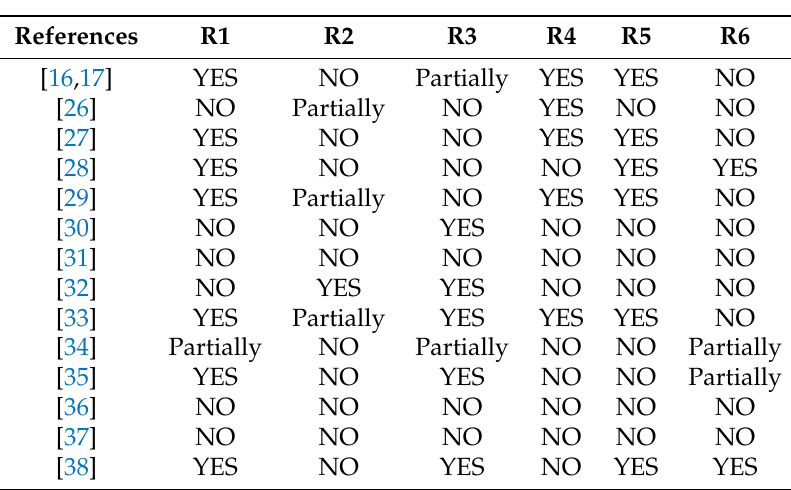
Table 1. Evaluated work